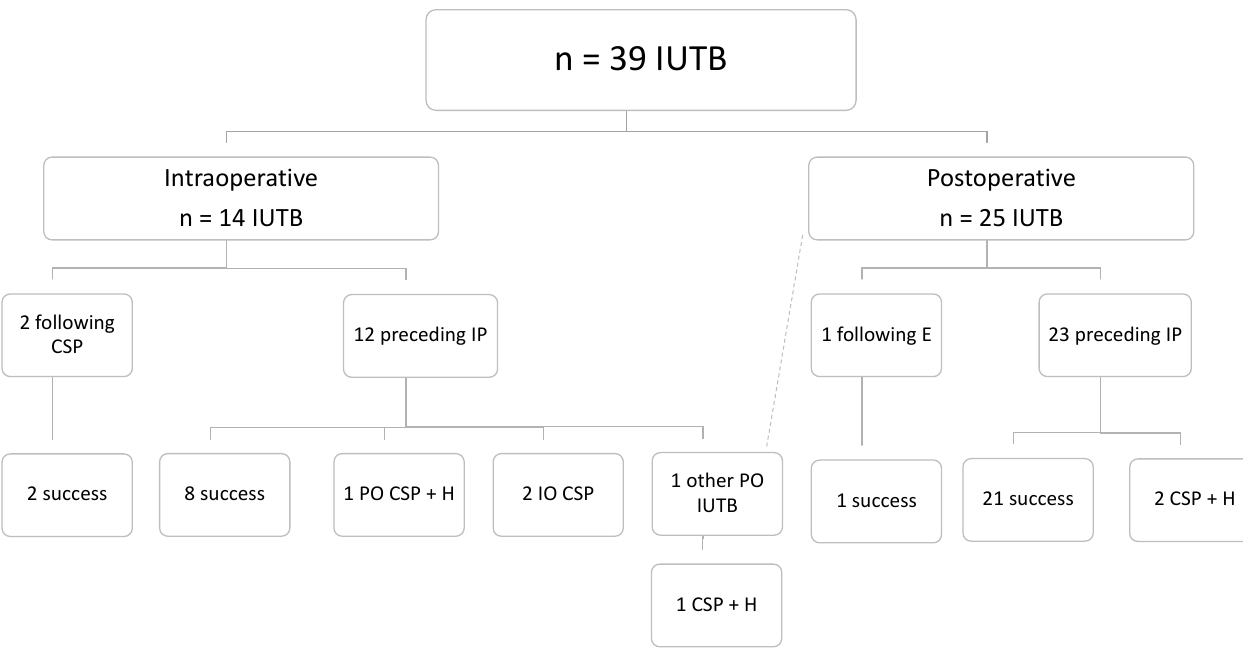
Figure 3. Flow chart representing the timing (intraoperative/postoperative) at which each intra-uterine tamponade balloon was used (thus, solely during the “post-balloon” period). IUTB: intra-uterine tamponade balloon; CSP: conservative surgical procedure; IP: invasive procedure; E: uterine artery embolization; H: hysterectomy; IO: intraoperative; PO: postop- erative.